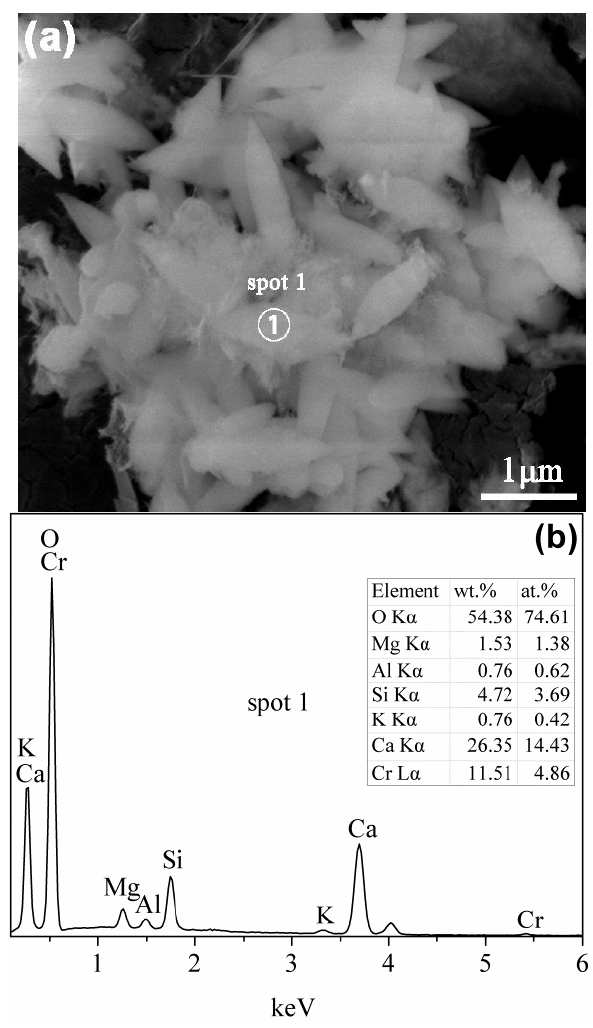
Figure 14. SEM image ( a ); and EDX spectra ( b ) of the tobermorite reacted with Cr(VI).